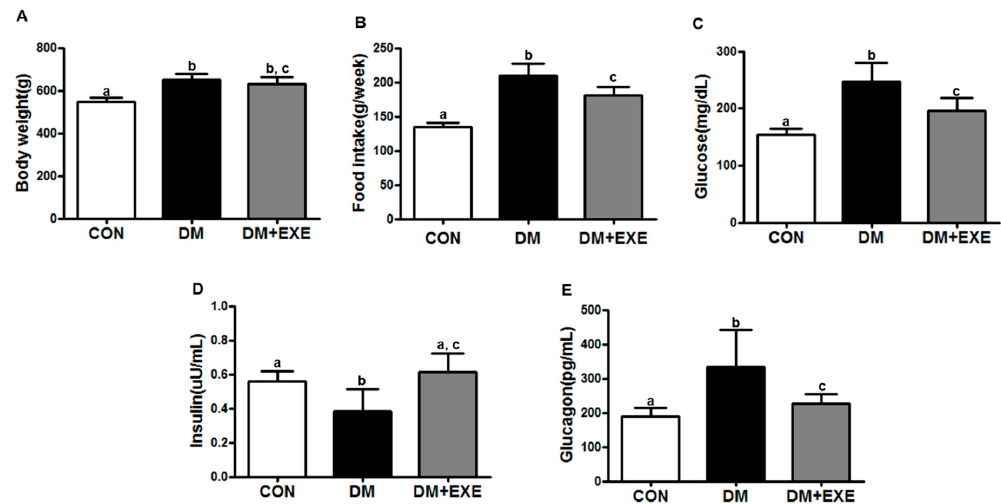
Figure 2. Resistance exercise training decreased food intake, glucose, and glucagon levels and increased insulin levels in T2DM rats. All data are presented as the Mean ± SD. ( A ) body weight, ( B ) food intake, ( C ) glucose, ( D ) insulin, ( E ) glucagon. CON: non-diabetic control group; DM: diabetic control group; DM + EXE: diabetic with resistance exercise training group. a, b, c Different letters indicate a significant difference between groups ( p <